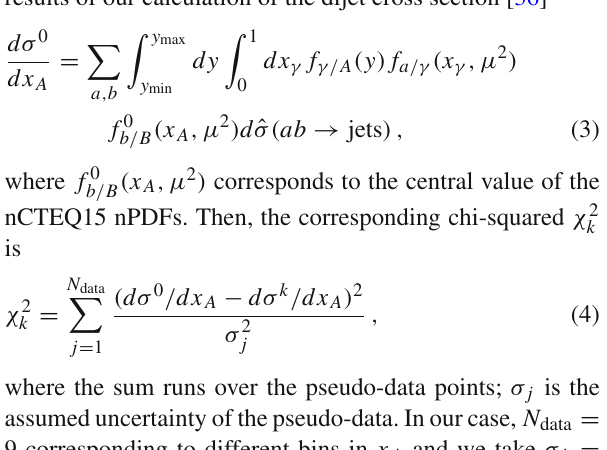
Table 1 The effective number of replicas N eff for different choices of the experimental error and sets of